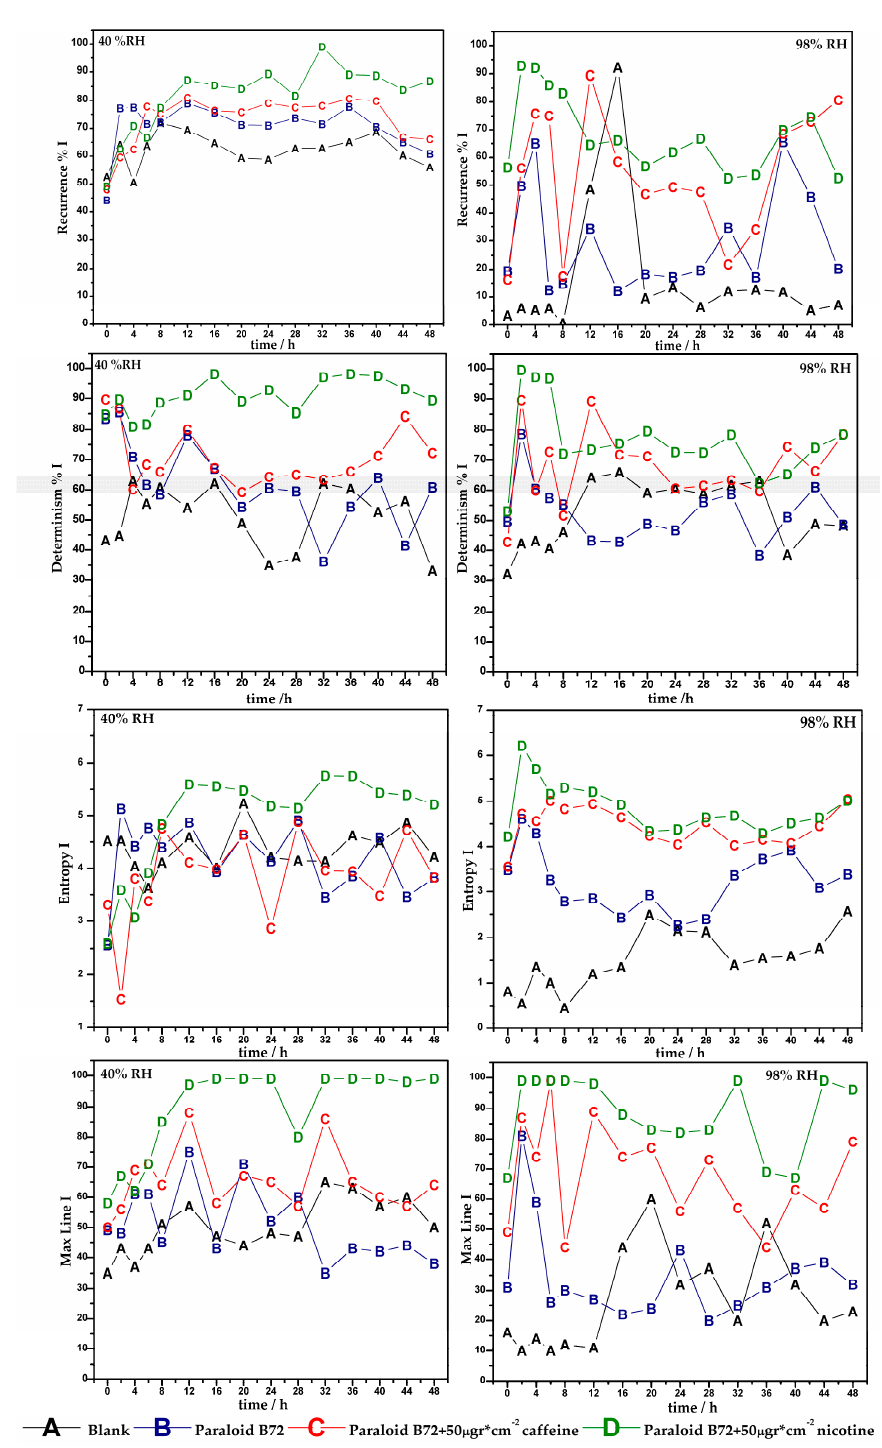
Figure 8. Recurrence time as a function of time in 40% and 98% relative humidity.